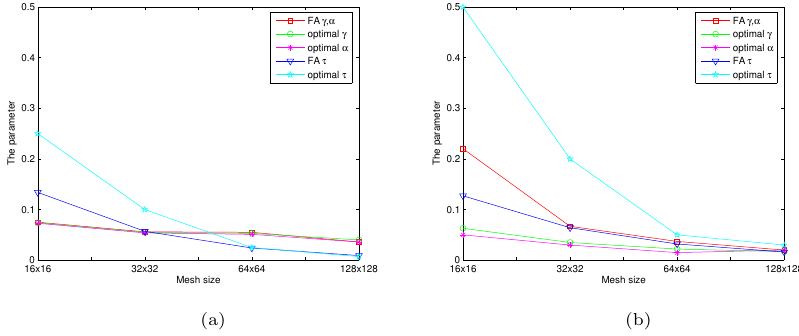
Figure 5. The parameters τ , α , γ change curves with respect to FA optimal and experimentally optimal vs. the mesh size in the RDF, SPP, and MAL preconditioners for steady Oseen problem (Q2-Q1, uniform grids). (a): ν = 0 . 01. (b): ν = 0 . 001.